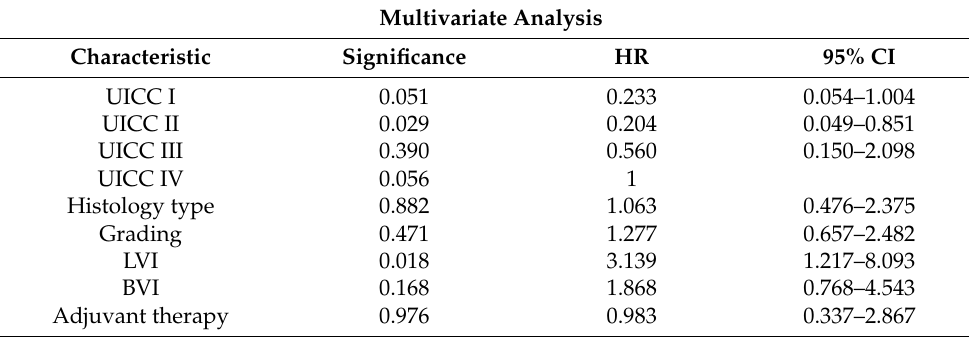
Table 3. Lymphatic vessel invasion correlated significantly with shorter